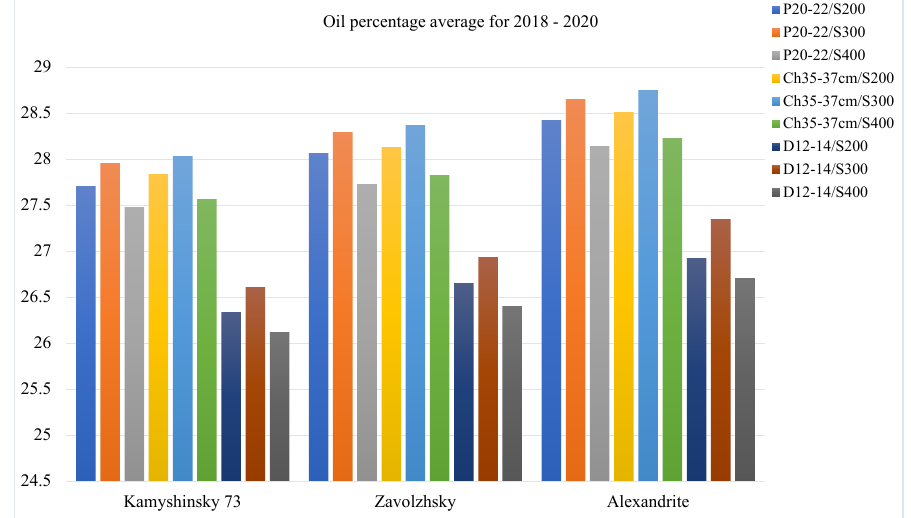
Figure 5. Interactive effect of different tillage techniques and seeding rates on average oil content. Abbreviations: P20–22/S200 represents moldboard plow PN-4-35 with depth of 20–22 cm/seeding